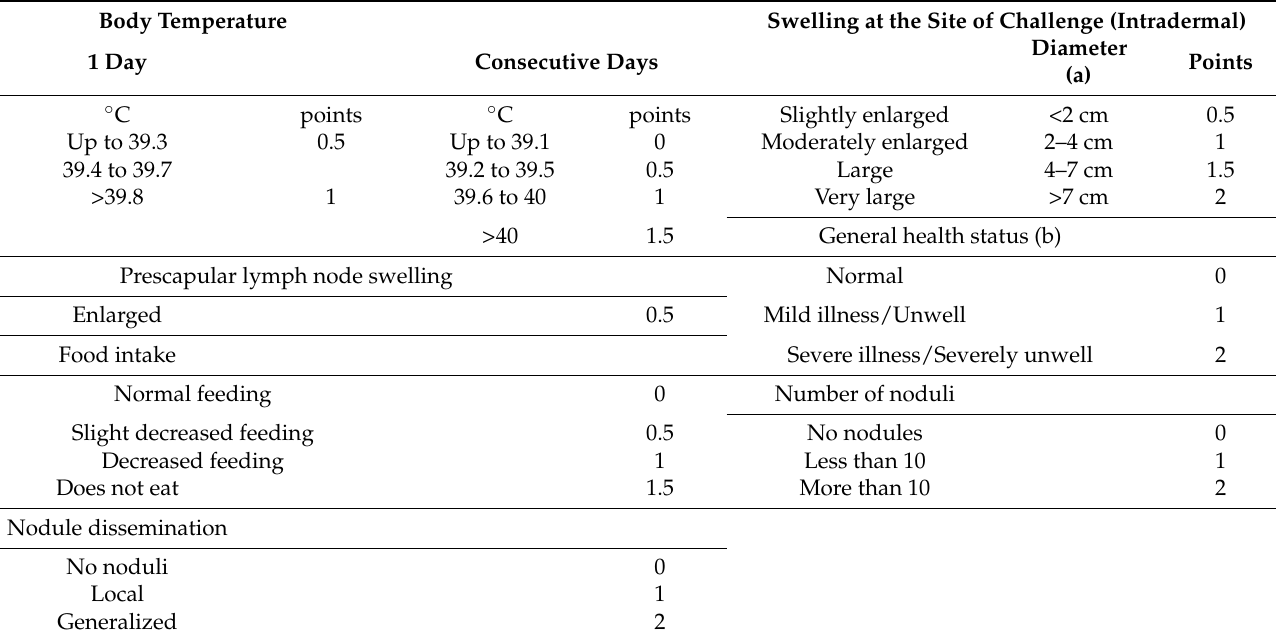
Table 1. Clinical scoring table. (a) The averaged diameter of the 4 intradermal inoculation sites in the neck; (b) Mild illness/Unwell: reduced responsiveness to stimuli, depression, reduced movement; Severe illness/Severely unwell: complete unresponsiveness, no movement (or laying